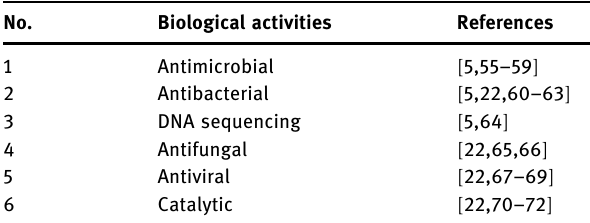
Table 2: Properties exhibited by AgNPs